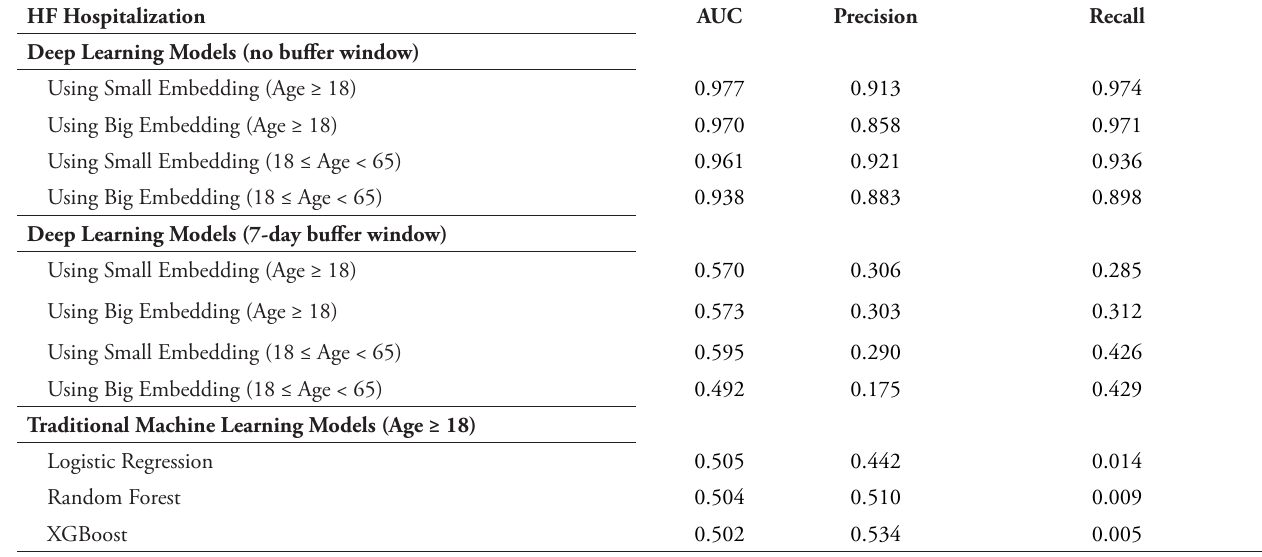
Table 2. Model Performance in Predicting Heart Failure Hospitalization Among Patients with Heart Failure with Reduced Ejection